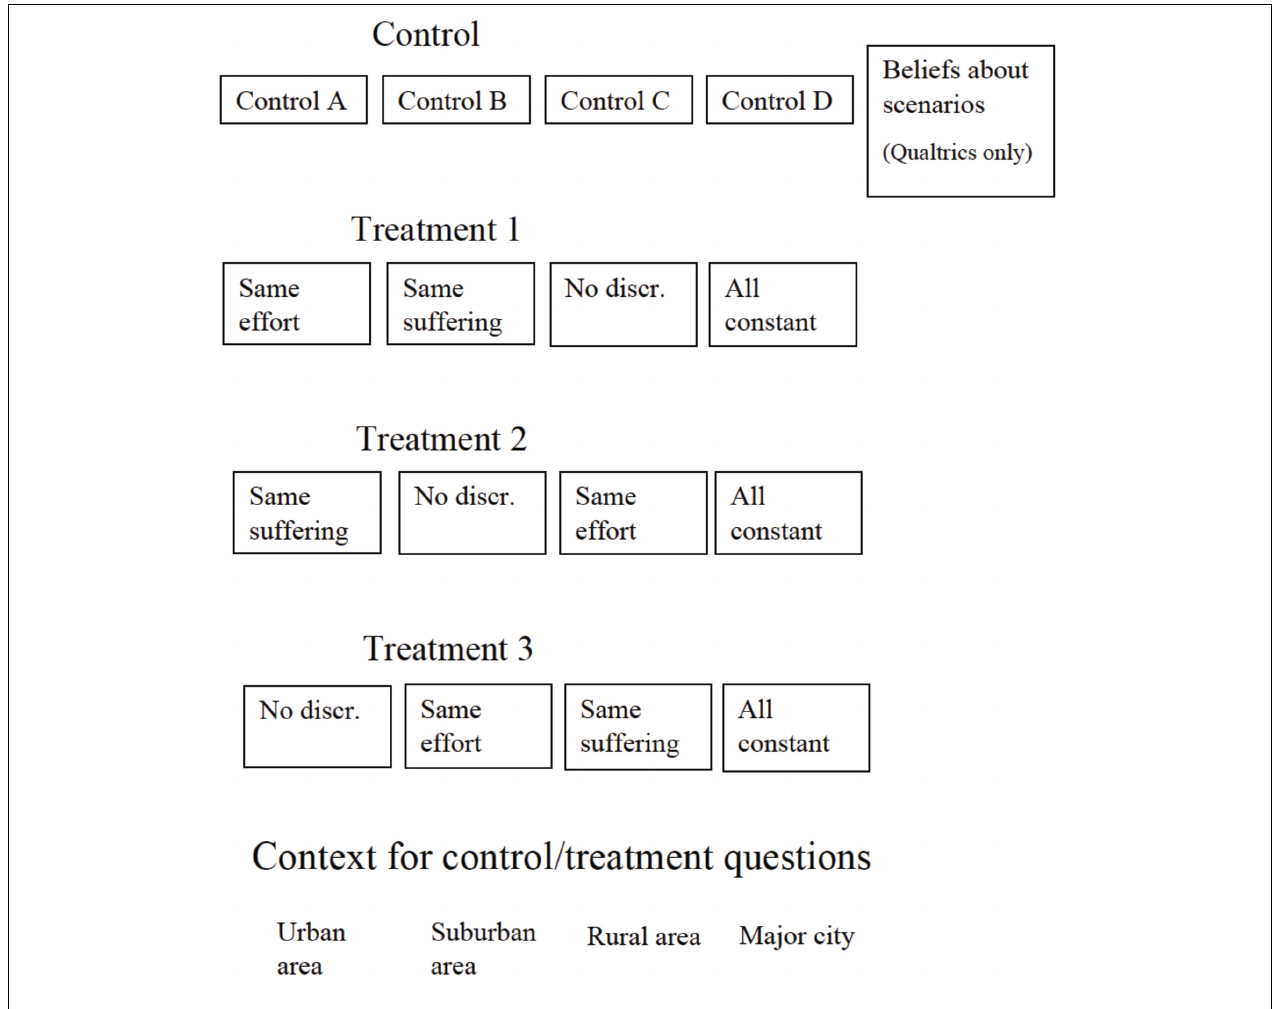
FIGURE 5 | Structure of embedded survey